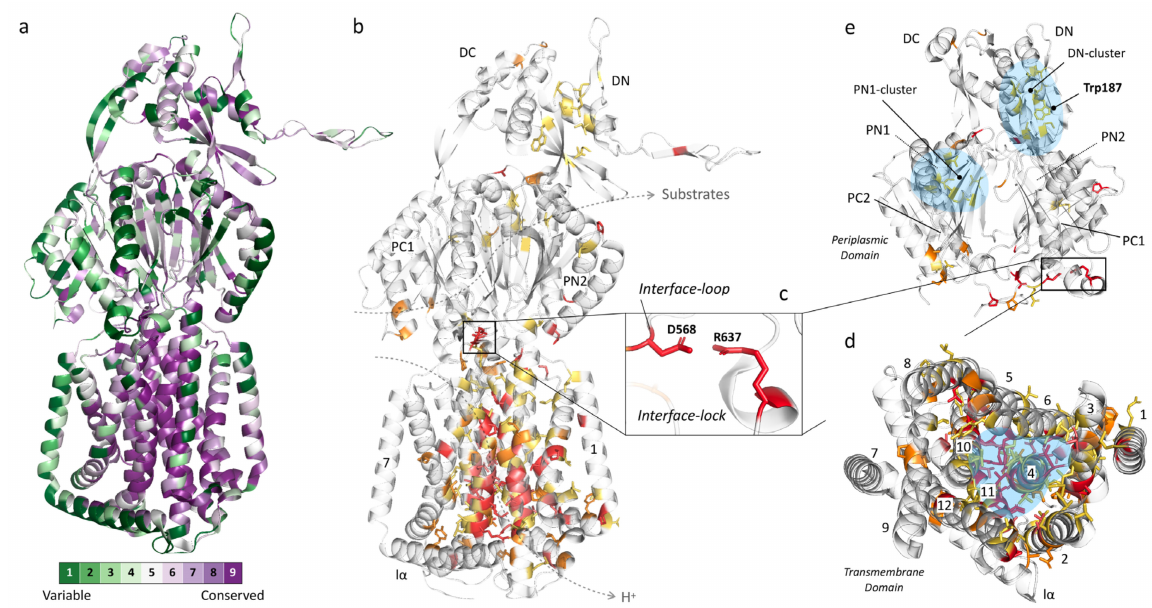
Figure 3. Heat maps of conservation, based on 135 sequences of RND multidrug efflux pumps. ( a ) Side view of AcrB-Ec showing conservation of the monomer, analyzed by using ConSurf [67,68]. Conservation is relative (most conserved “category 9” (dark purple) ranges from 50% to 100% identically conserved depending on the residue; Table 3 and Table S1). ( b ) Manual conservation heat map based on Clustal Omega [65]. Residues can be found in Table 2. ( c ) The “interface-lock” between D568 from the “interface-loop” and R637 from the PC1 subdomain. ( d ) Top-down view of the transmembrane domain. ( e ) Outside-in view of the periplasmic domain. Dashed lines indicate located at the back (for PN1 and PN2). Coordinates from high-resolution AcrB-Ec (using DARPin inhibitors, PDB accession code 4DX5 [54]). Colors: ( a ) Green, variable regions; purple, conserved regions. ( b – e ) Red, fully conserved among all 135 pumps; light red, conserved among the 19 selected pumps while also highly conserved in all 135 pumps; orange, fully conserved in 19 pumps; yellow, highly conserved in all 135 pumps; blue, conserved hydrophobic